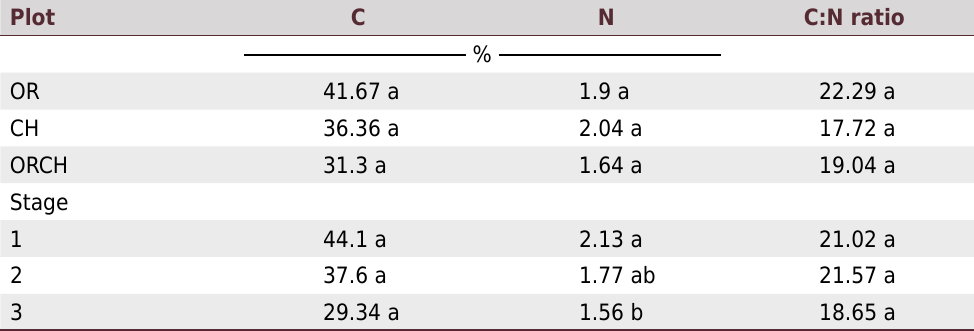
Table 3. Leaf litter carbon, nitrogen, and carbon to nitrogen ratio within plots and composite averages for three decomposition stages